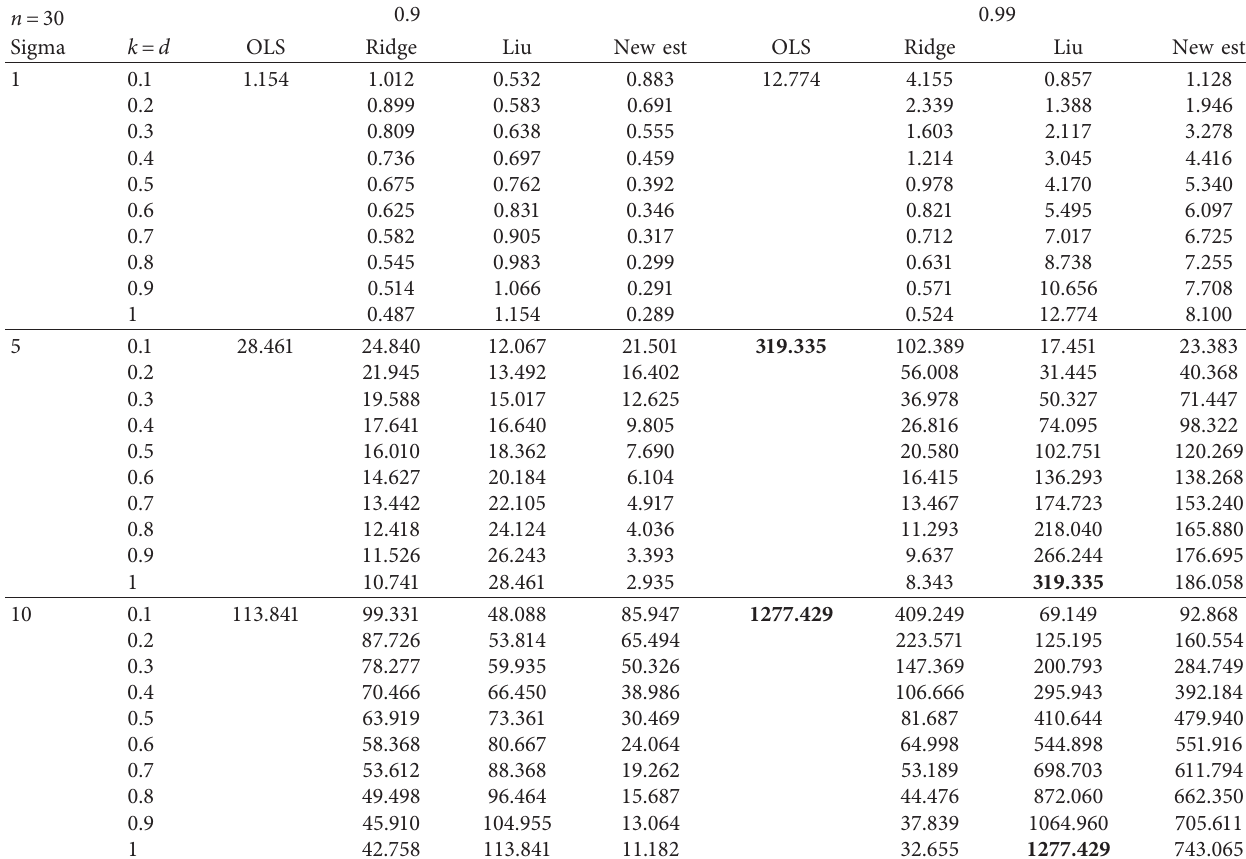
Table 2: Estimated MSE when n � 30, p � 3, and ρ � 0.90 and 0.99.